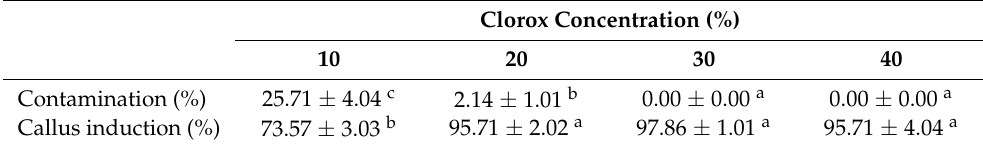
Table 1. Effect of Clorox concentration on rice callus induction. Figure 1. Effect of Clorox concentration ( a ) and incubation time ( b ) on phenolic content. Data with